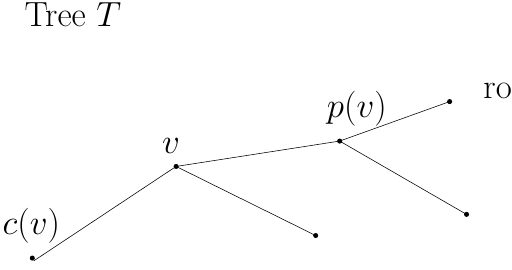
Figure 2. This figure depicts a tree T